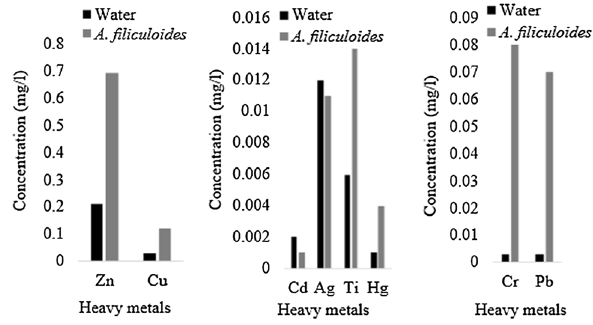
Fig. 2 Heavy metals in the samples of water and A . filiculoides in the eastern part of the wetland